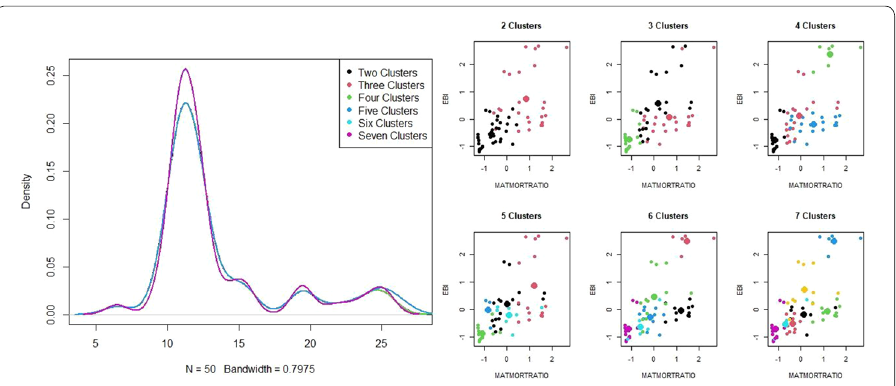
Fig. 7 Within and between cluster variations for the clusters on the RHS based on 60 sample